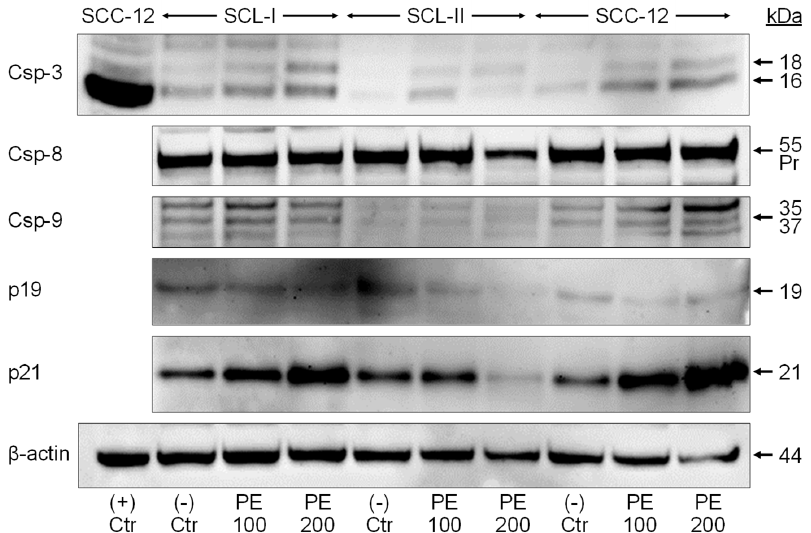
Figure 4. Weak caspase activation. Expression of caspase-3, caspase-8, caspase-9, p19, and p21 is shown by Western blotting in cell lines SCL-I, SCL-II, and SCC-12. Cells were treated for 24 h with PE (100, 200 μ g/mL). Protein size (in kDa) is indicated on the right side, as determined in comparison to a protein size marker separated in parallel. Caspase activation is seen either by characteristic cleavage products, as 18/16 kDa for caspase-3 and 35/37 kDa for caspase-9 or by loss of the caspase-8 proform (55 kDa). For demonstrating full caspase-3 activation, a positive control is shown, (+)Ctr, consisting of SCC-12 cells treated with an indirubin derivative in combination with the death ligand TRAIL (TNF ‐ related apoptosis ‐ inducing ligand [24] . Expression of β‐ actin is shown as loading control. Largely similar results were obtained in two independent Western blot experiments using independent series of cell extracts.